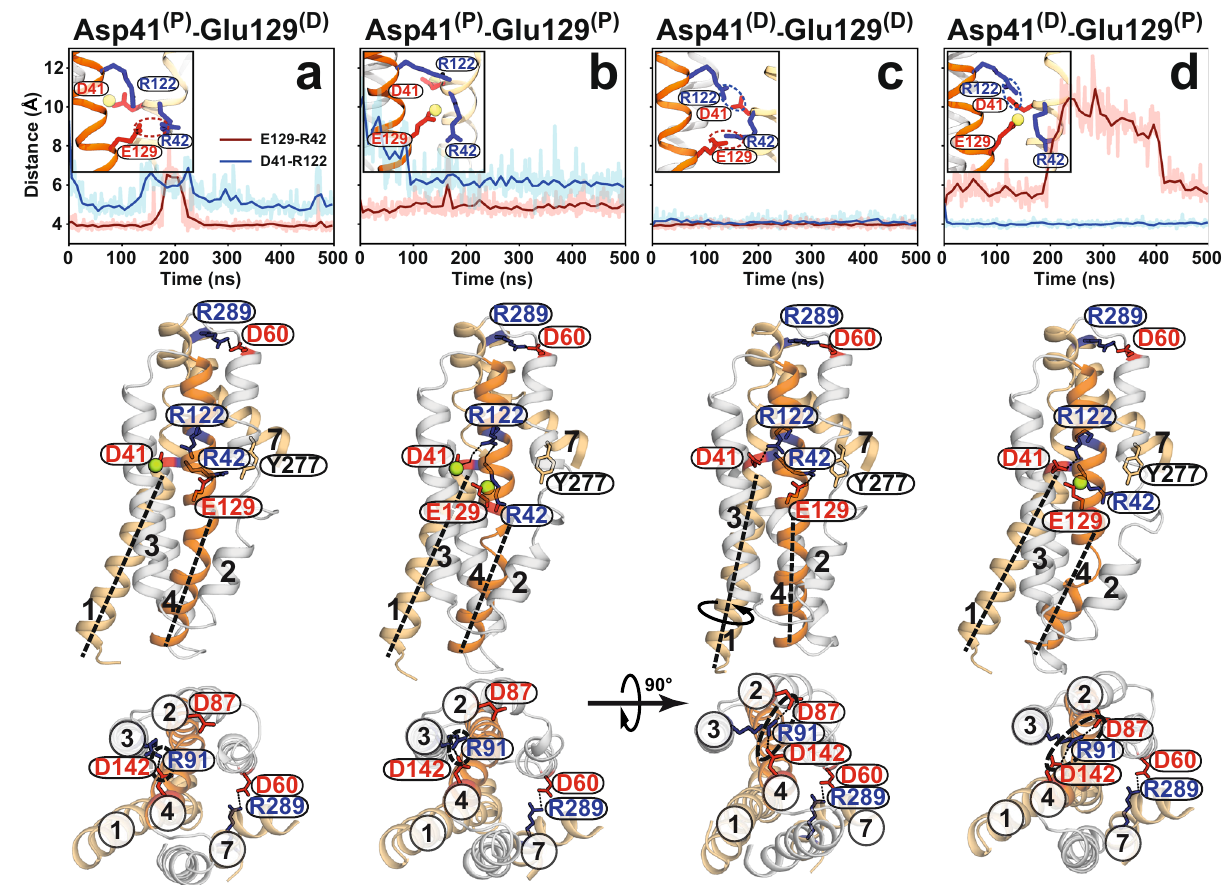
Fig. 6 | Proton dependence of luminal salt bridges in Hn Spns involving sub- stratebindingresidueArg42. Timeseries(lightcolor)andmovingaverages(dark color)ofGlu129-Arg42(red)andAsp41-Arg122(blue)side-chaindistancesfromMD simulations of the IF Hn Spns structure in the membrane are used to monitor the stabilityoffunctionallyrelevantsaltbridgesinsimulationsunderdifferenttitration states ( a – d ) of Asp41 and Glu129 (indicated by D and P for deprotonated and protonated, respectively). Data for all simulation replicas are shown in Supple- mentary Fig. 6. Representative snapshots of the molecular structure from each simulation condition are shown from the side (middle panels) and cytoplasmic